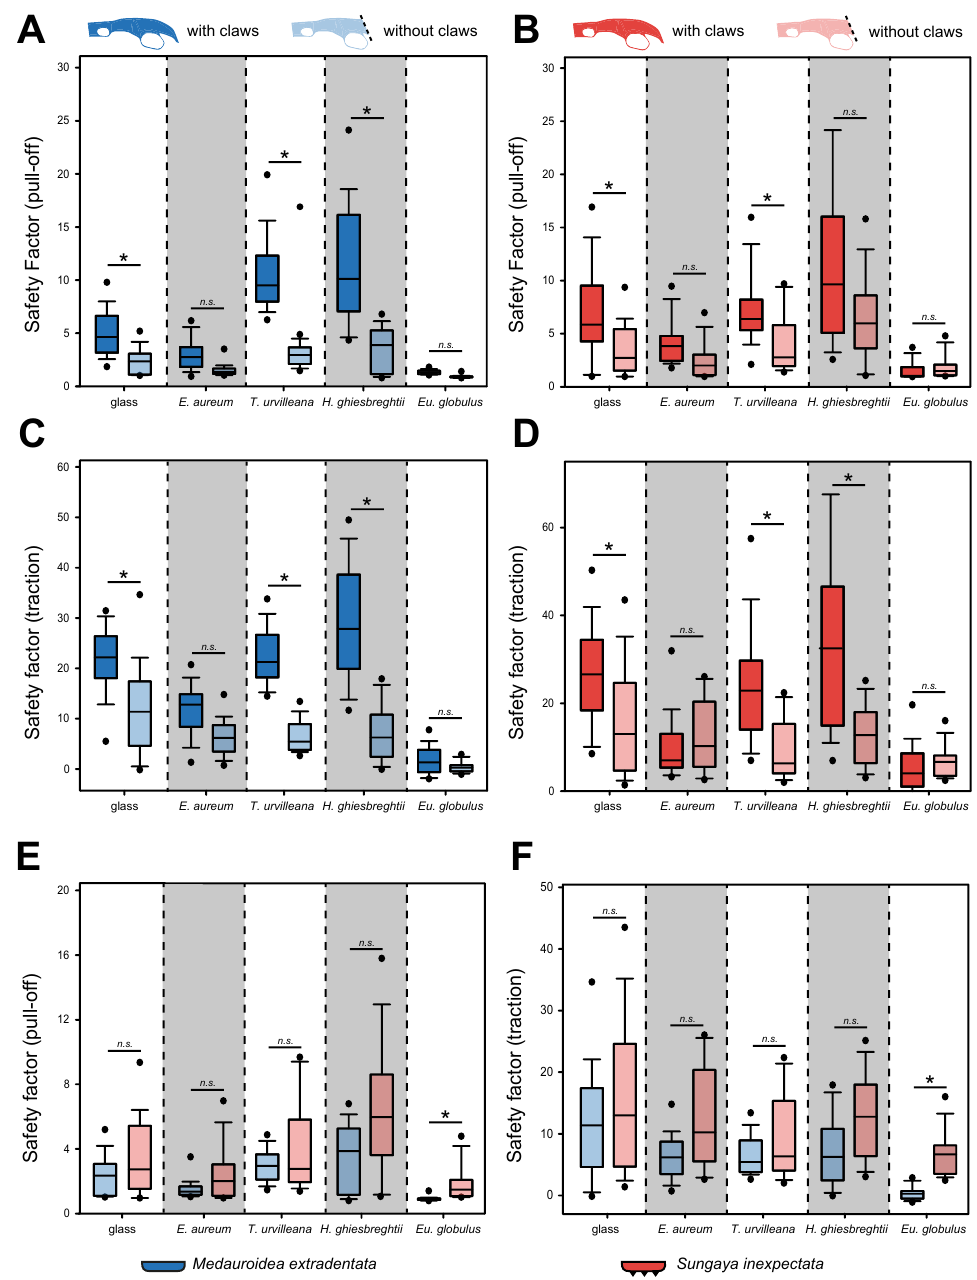
Figure 5. Safety factors of M. extradentata and S. inexpectata with claws and without claws on different substrates. ( A ) Pull-off force measurement of M. extradentata with and without claws. ( B ) Pull-off force measurement of S. inexpectata with and without claws. ( C ) Traction force mea- surement of M. extradentata with and without claws. ( D ) Traction force measurement of S. inex- pectata with and without claws. ( E ) Pull-off force measurement of both species without claws. ( F ) Traction force measurement of both species without claws. Groups which do not differ signif- icantly from each other are marked n.s. and groups which differ with a significance of p > 0.05 are marked * for each substrate. Kruskal–Wallis one-way ANOVA on ranks (( A ): H = 287.832, ( B ): H = 276.410, ( C ): H = 179.328, ( D ): H =171.182, ( E ): H = 126.899, ( F ): H = 100.812; p ≤ 0.001, d.f. = 9, N without_claws = 10, N with_claws = 15) and Dunn’s method ( A – D ; p < 0.05) or Turkey’s test ( E , F ; p < 0.05). The boxes indicate 25th and 75th percentiles, whiskers define the 10th and 90th per- centiles and the line within the boxes represents the median. Outliers are shown as individual